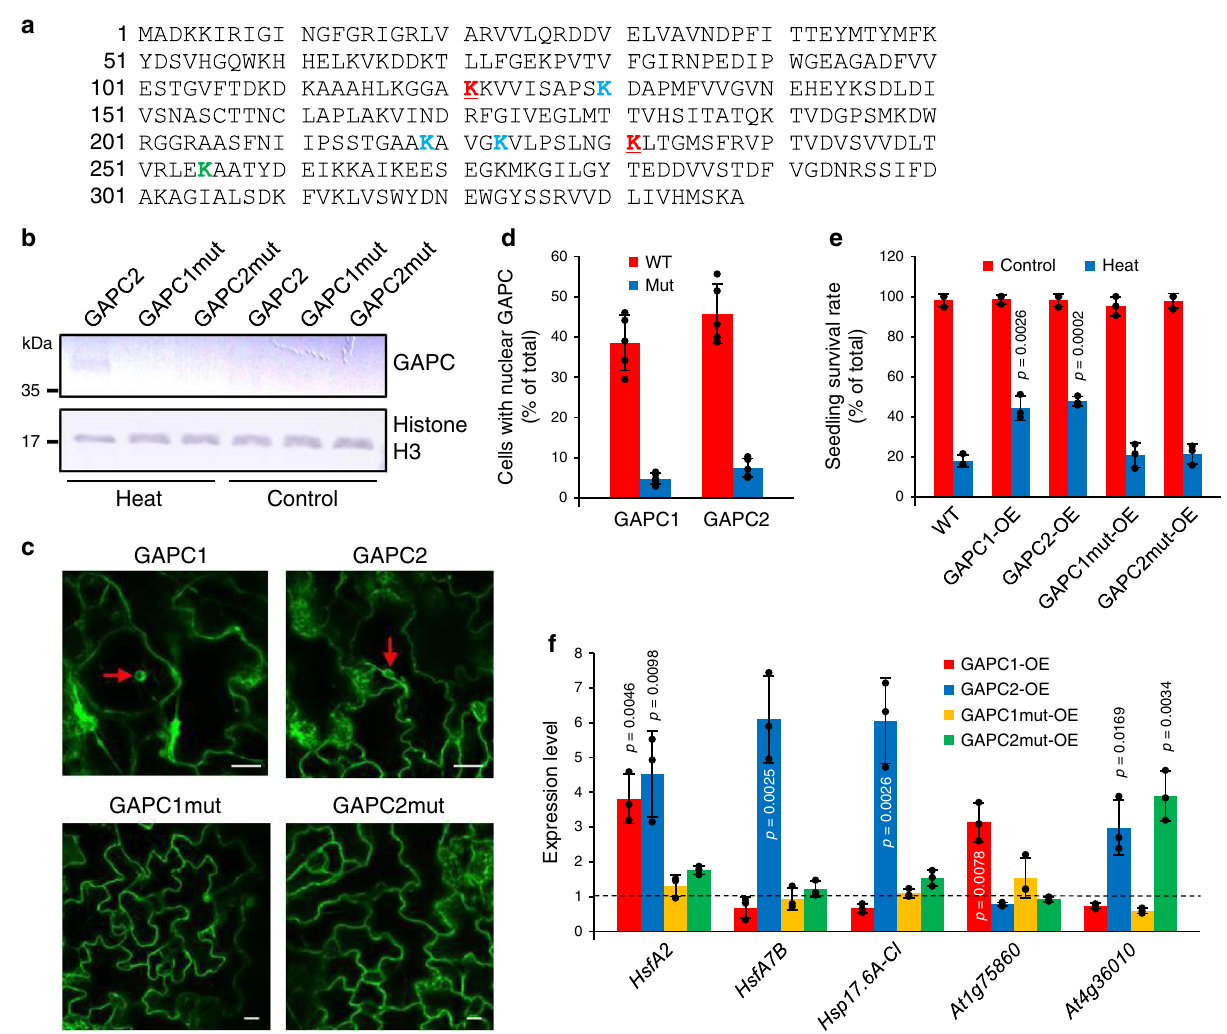
Fig. 7 Effects of GAPC mutation on heat response. a GAPC2 amino acid sequence. Colored are the lysine residues required for HsGAPDH nuclear localization (K121 and K231 in red, K255 in green) and found to be acetylated in E. coli (K130, K219, and K223 in blue, K255 in green). The lysines mutated in this study are underlined. b Immununoblotting of GAPC in nuclear fraction. Five-day-old transgenic seedlings overexpressing the indicated GAPC-Flag were untreated (Control) or treated at 40°C for 6h. Nuclei were isolated and GAPC was probed with an anti-Flag antibody by immunoblotting. Histone H3 was used as a nuclear marker. GAPCmut, GAPC with K121A/K231A. c Fluorescence images of Arabidopsis leaf cells. Five-day-old seedlings overexpressing the indicated GAPC-GFP were treated at 40°C for 6h and observed under a confocal microscope. Arrows indicate the nucleus. Scale bars = 10 µ m. d The number of cells with nuclear GAPC. Plants were treated and observed as in c . Cells with clear fl uorescence in the nucleus were counted and shown here as % of total cells counted. Values are average±S.D. from 5 leaves independently treated. Black dots represent individual data points. e Quantitative measurement of heat response. Plants were untreated (Control) or treated at 40°C for 6h and measured for seedling survival rate. Values are average±S.D. P values indicate signi fi cant difference from WT determined by two-tailed student ’ s t test ( n = 3 independent groups of >30 seedlings). Black dots represent individual data points. f Expression of heat-inducible genes. Total RNA was extracted from 5-day-old seedlings treated at 37°C for 5h and quantitative RT-PCR was performed with gene-speci fi c primers. Values are average±S.D. and shown as fold change to WT (dashed line). P values indicate signi fi cant difference from WT determined by two-tailed student ’ s t test ( n = 3 independent groups of >10 seedlings). Black dots represent individual data translocation but neither acetylated in Arabidopsis nor required for OsGAPDH1 nuclear localization, are suf fi cient for the GAPC